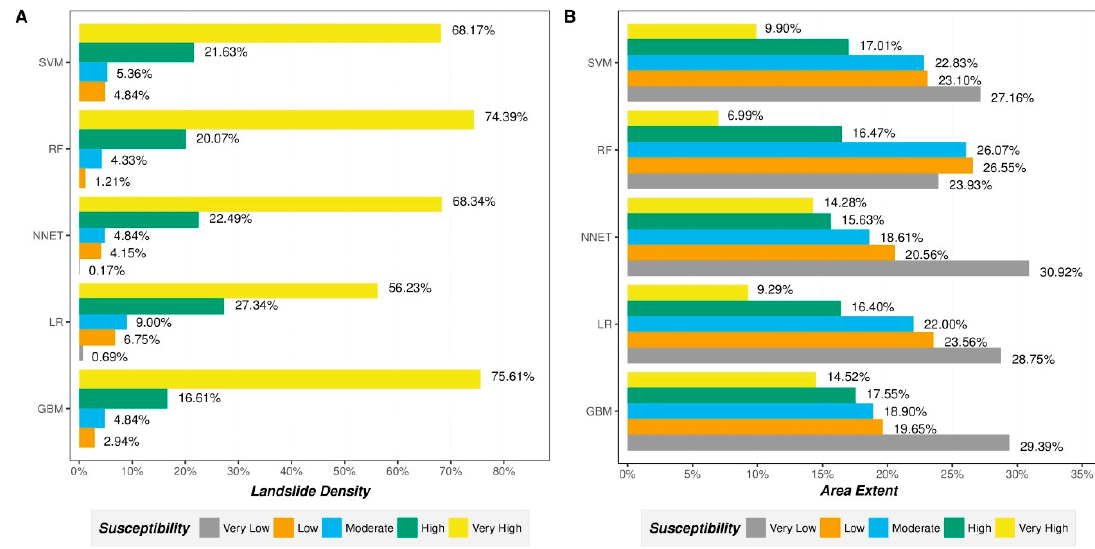
Figure 11 . The sufficiency analysis of the susceptibility maps: ( A ) Landslide density distribution by susceptibility zones; ( B ) the total area extent covered by susceptibility zones.